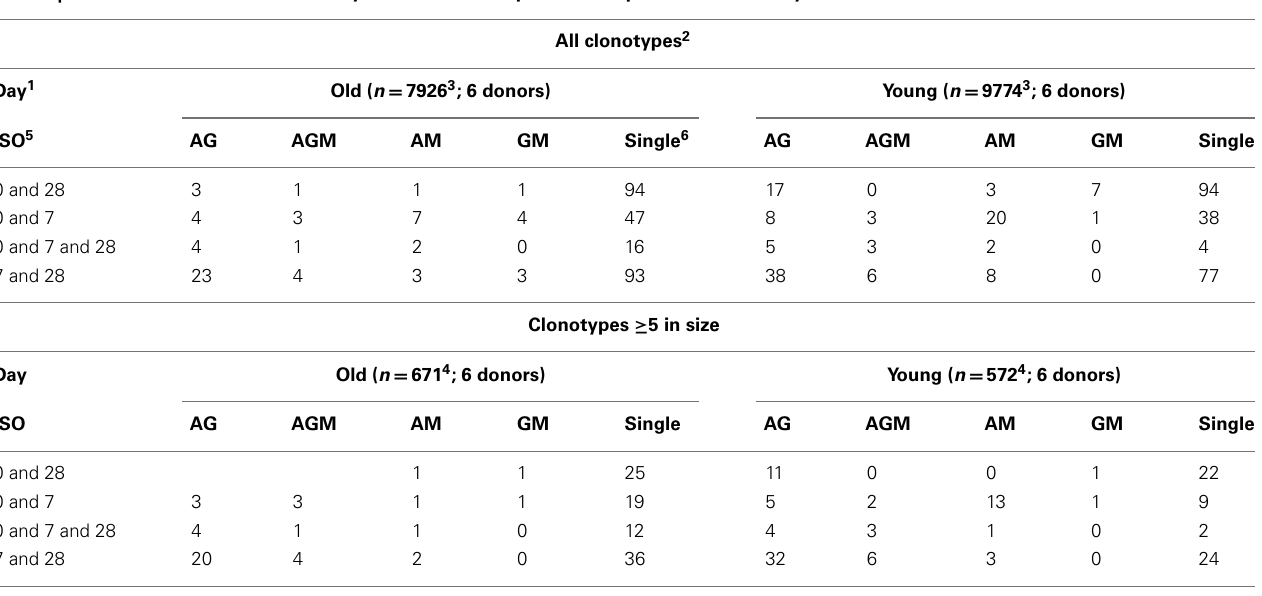
Table 2 | Numbers of clones with clonality between IGH sequences sampled at different days 1